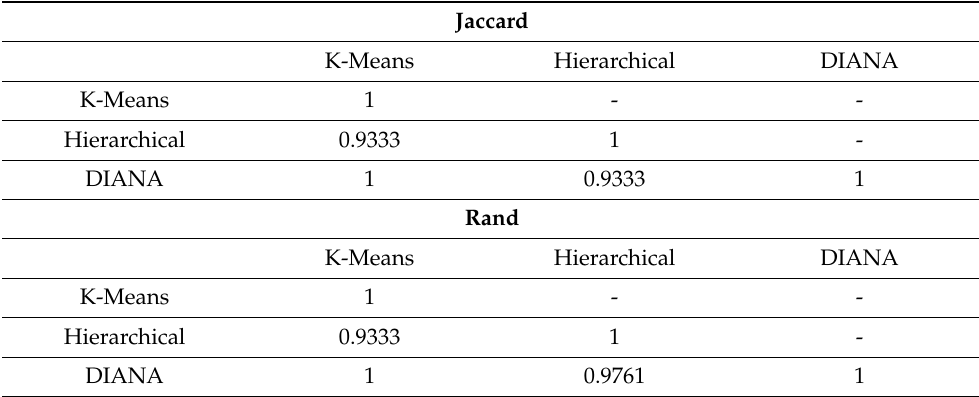
Table 4. The Jaccard and Rand metrics for the analysed techniques.